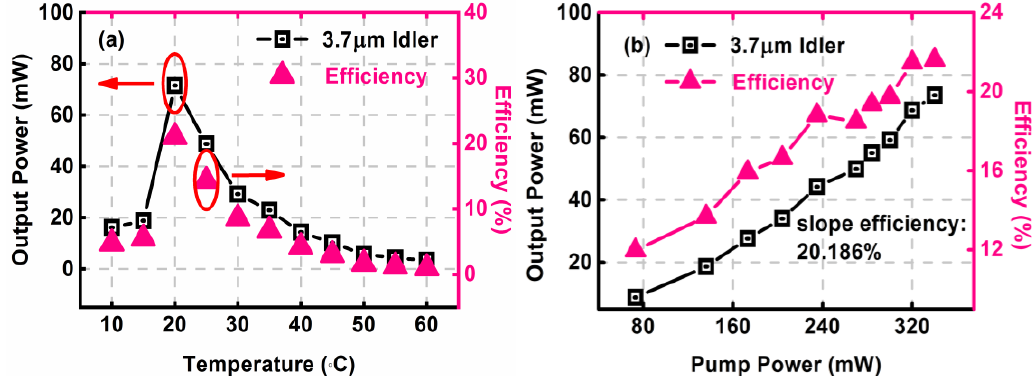
Figure 5. Measured idler power and conversion efficiency under different ( a ) temperatures and ( b ) pump powers.